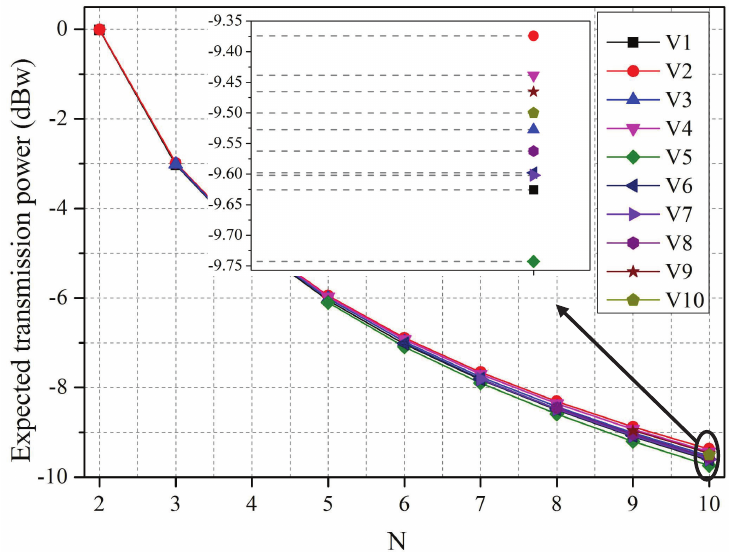
Figure 3. Optimal strategies of followers vs. the number of co-located WBANs.